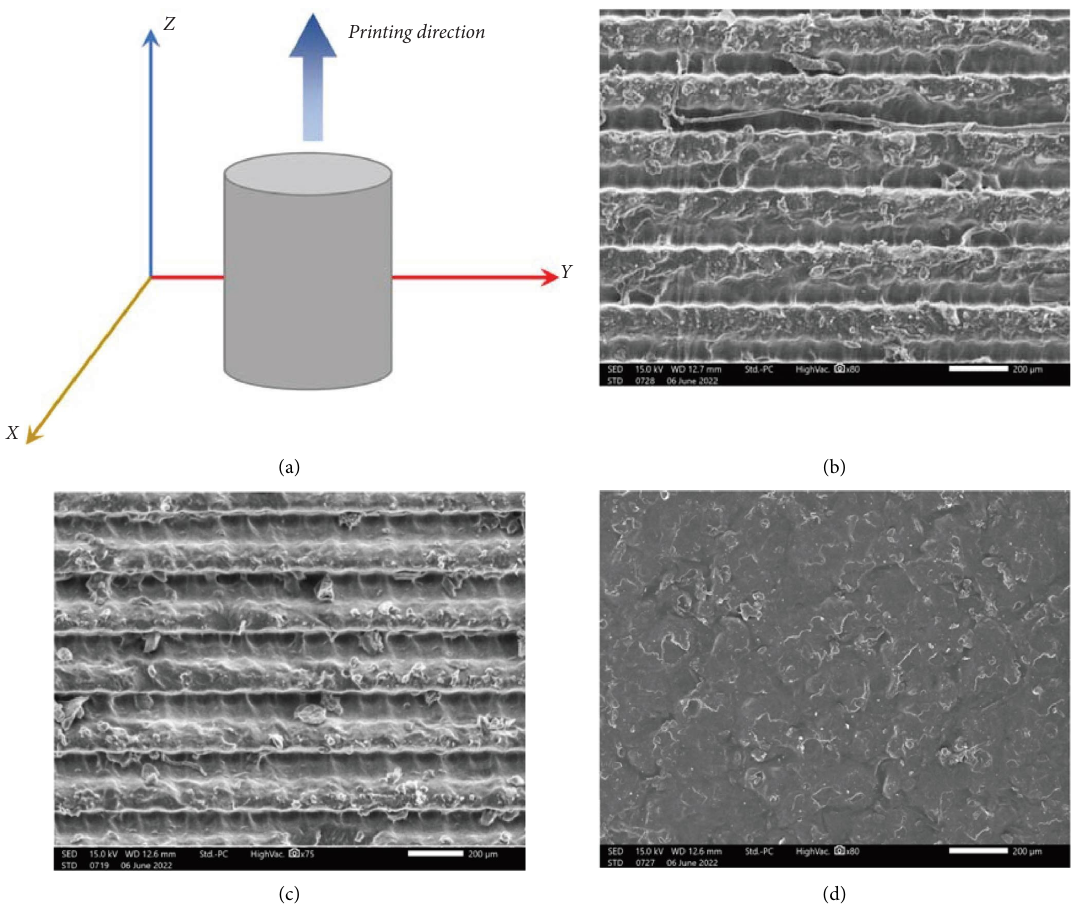
Figure 6: Te material distribution of 2.5D infll structures through (a) printing direction and printed samples SEM images along (b) X -axis, (c) Y -axis, and (d) Z